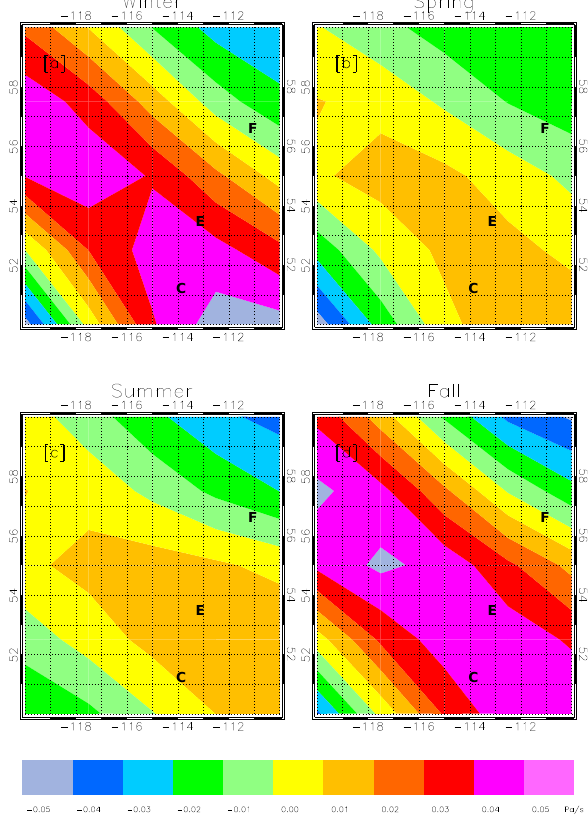
the southern area. This highlights the important role of mete- orological parameters on ambient air quality. Figure 4. Spatial distributions of omega at pressure level 850mb for